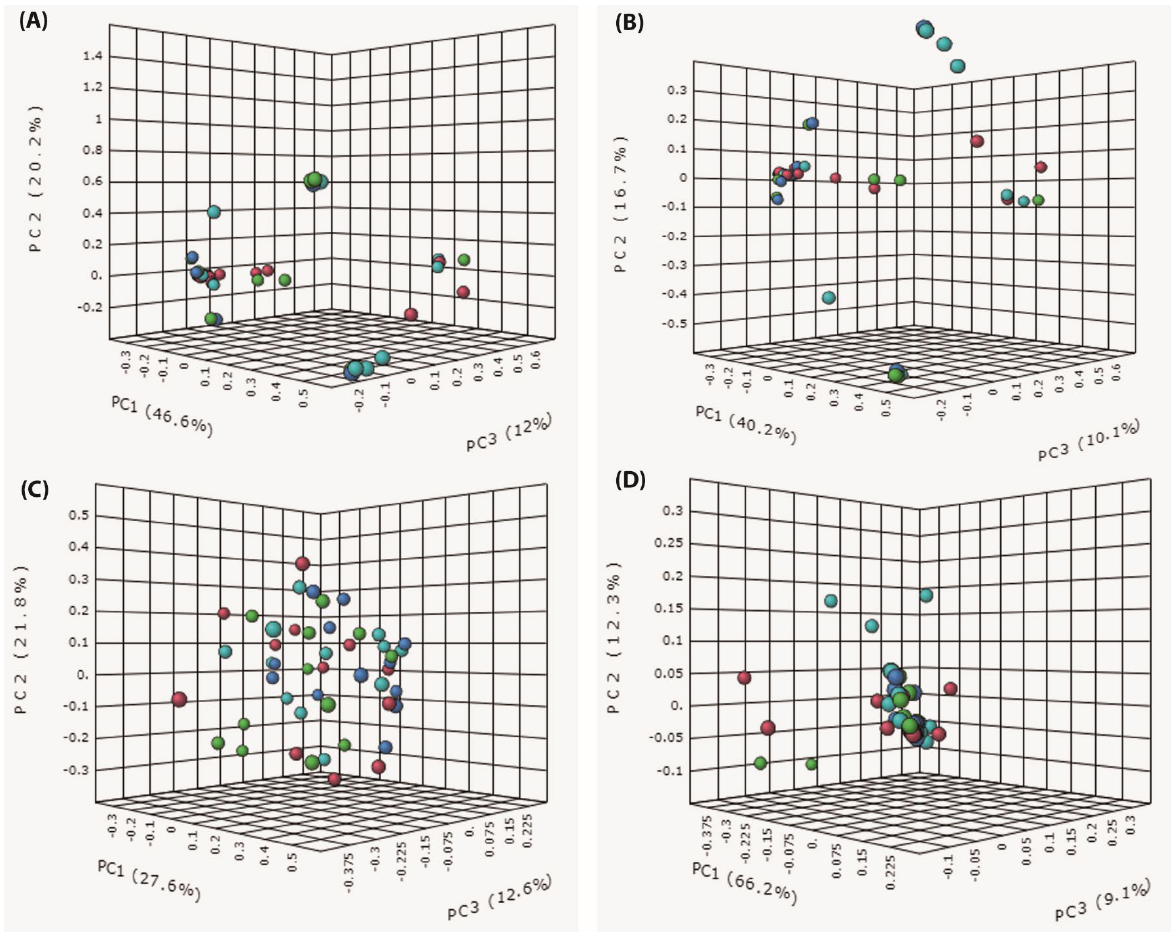
Figure 5. Beta diversity indices shown as two-dimensional principal coordinate analysis (PCoA) plots of vaginal microbial communities across the three trimesters of pregnancy in comparison to non-pregnant state. Beta diversity was calculated by ( A ) Bray–Curtis index and ( B ) Jaccard index ( C ) unweighted UniFrac test ( D ) weighted UniFrac test. A p value < 0.05 is considered statistically significant.